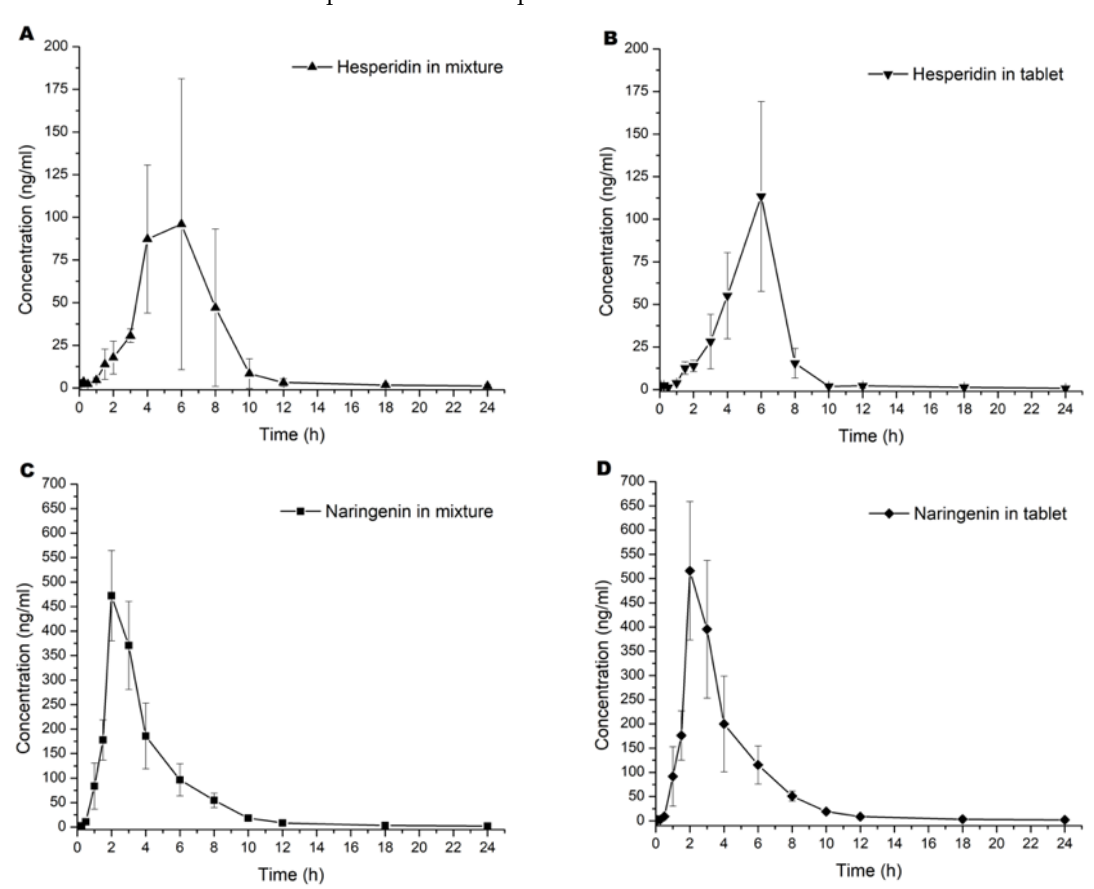
Figure 2. Pharmacokinetic curves of the serum mean concentration versus time of ( A ) hesperidin in mixture, ( B ) hesperidin in tablet, ( C ) naringenin in mixture, and ( D ) naringenin in tablet. Values are expressed in mean ± SD. Table 1. Pharmacokinetic parameter results of hesperidin and naringenin in Mix-160 and tablet.